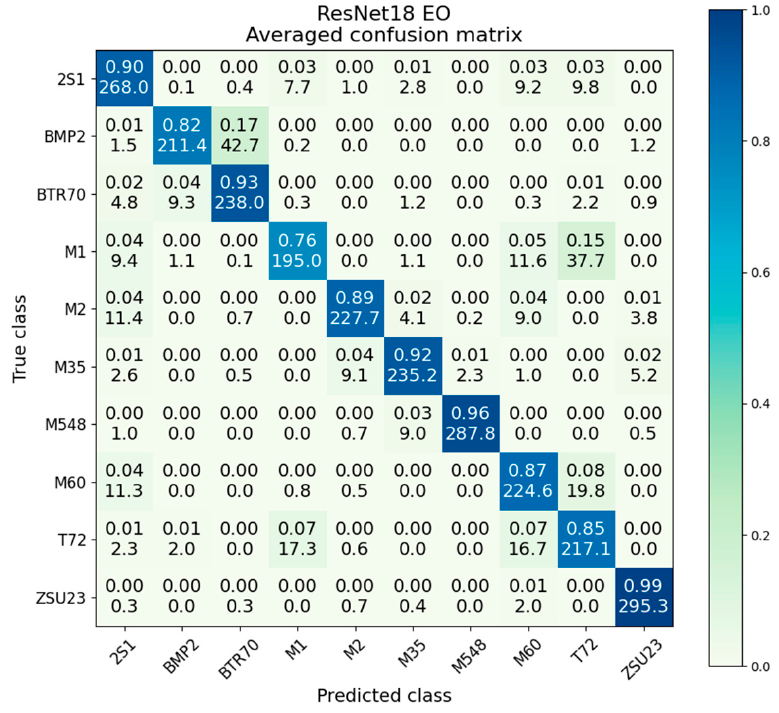
Figure 11. Averaged confusion matrix for ResNet18 on EO data.